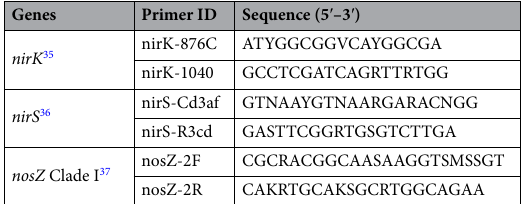
Table 1. Primers for amplification of denitrifying genes in this